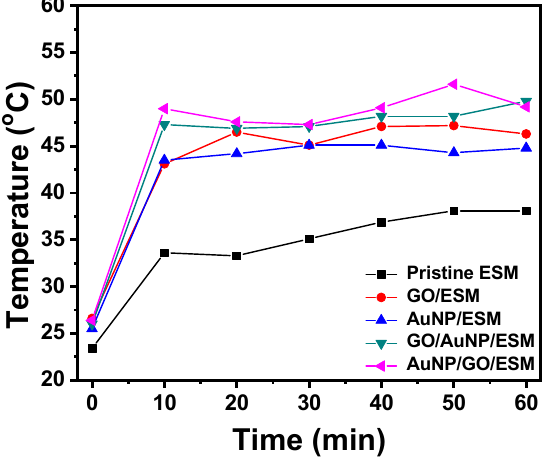
Figure 7. Evolution of the temperatures of ESM samples during simulated sunlight irradiation under the xenon lamp.